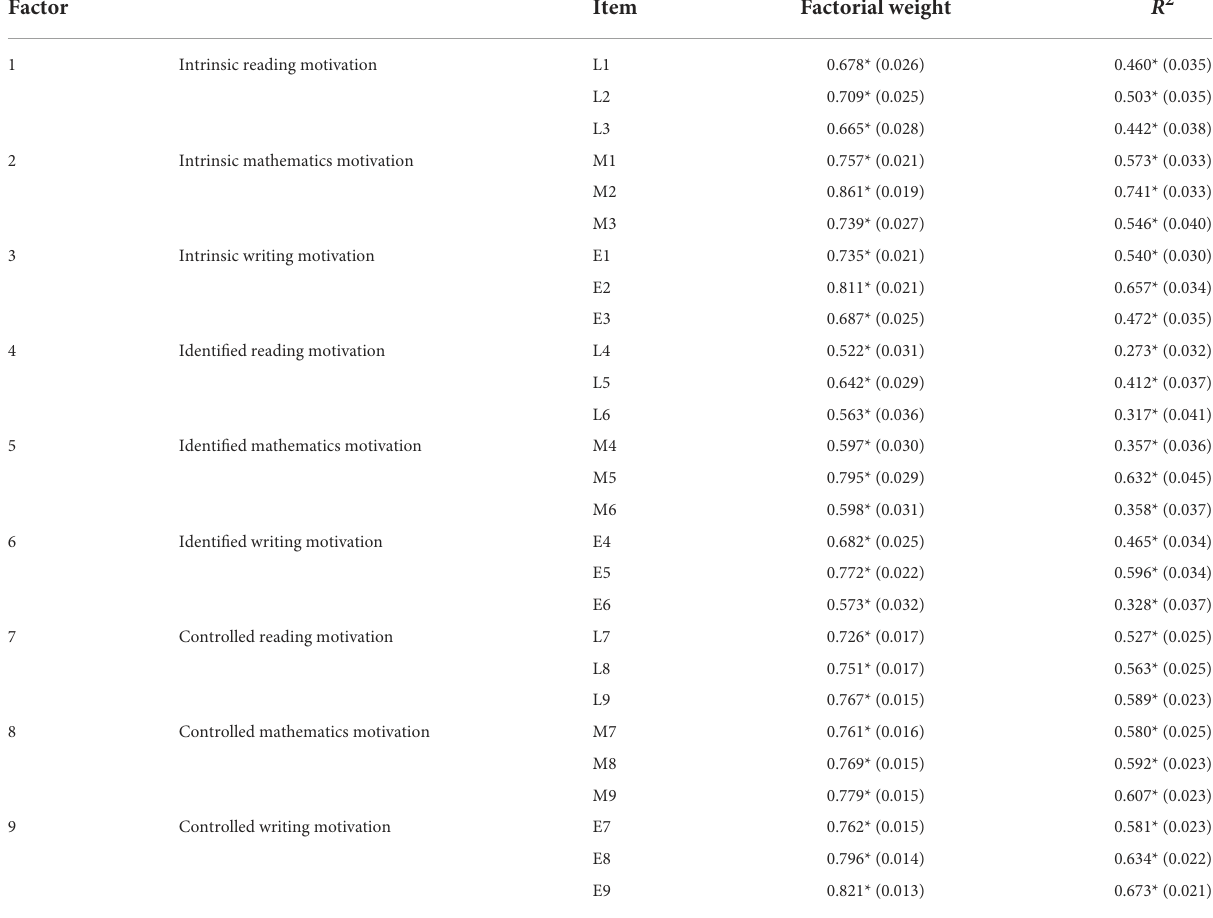
TABLE 6 Factorial weights and shared variance between item and factor.